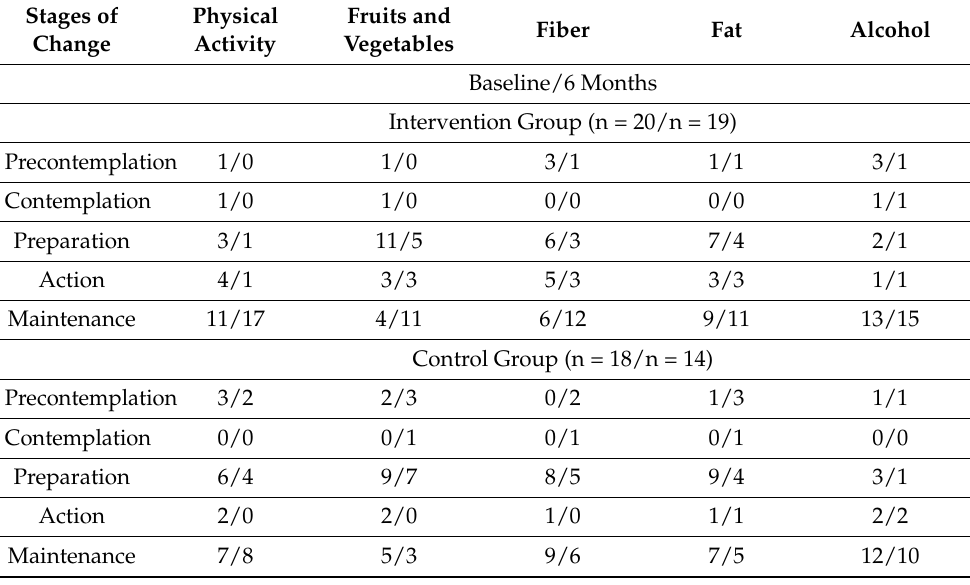
Table 5. Frequency of Stages of Change for Each Parameter at Baseline and 6 Months for People Living with HIV and Prediabetes in Intervention and Control Groups of a Nutrition Intervention to Progress through Stages of